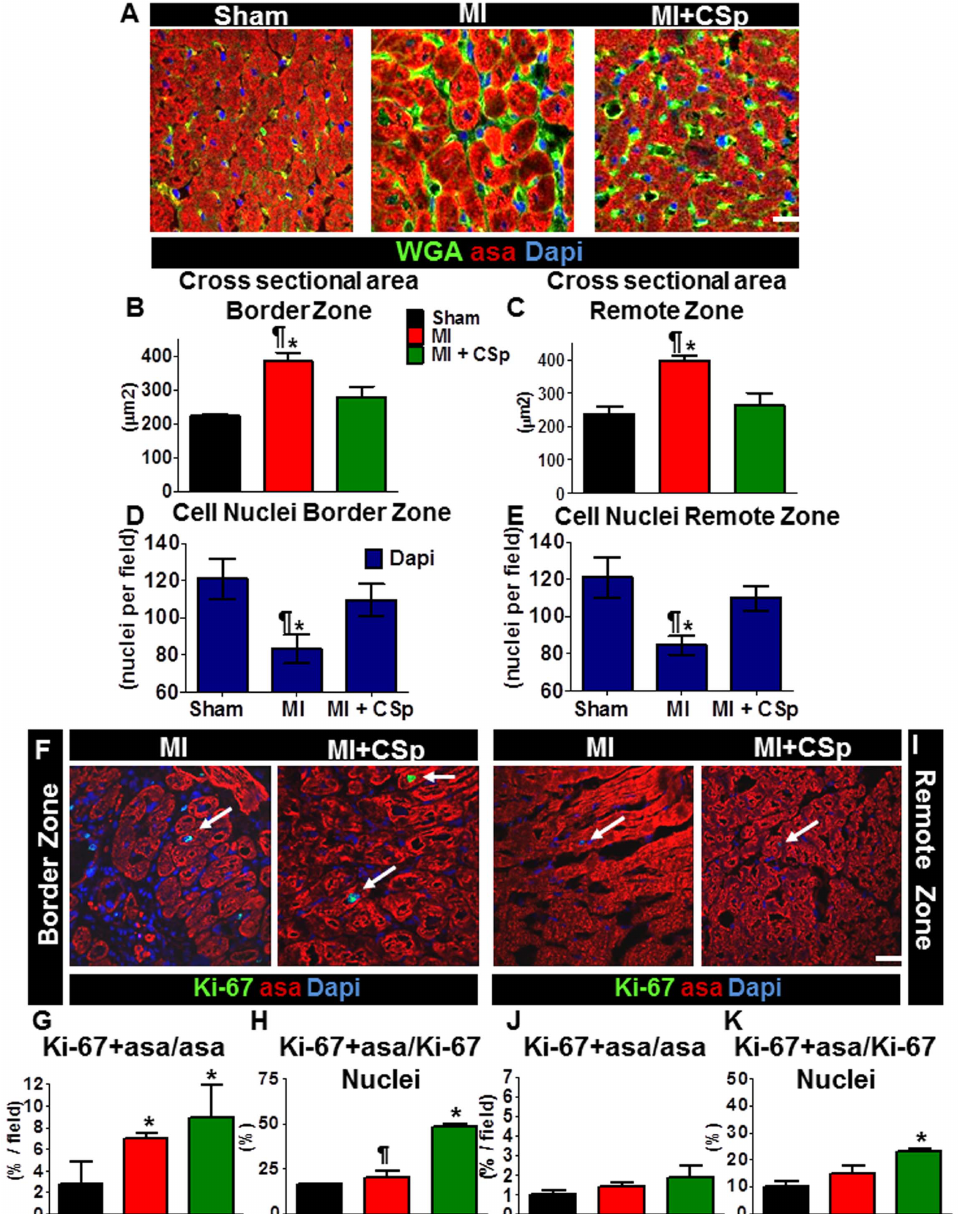
Figure 2. Cardiac tissue structure. (A) Representative photomicrographs of immunohistochemical staining of smooth muscle actin, wheat germ agglutinin, and Dapi in myocardial tissue sections. Five different heart tissues per group were stained. Approximately 10–15 high-power fields per area from a minimum 3 slides per heart were analyzed to obtain the average regional cross sectional area and regional myocyte nuclear density. 100 cardiomyocytes per heart were evaluated. (B) Quantification of cross-sectional area in the peri-infarct and D. in the remote zone respectively. (C,E) Measurement of the total number of cell nuclei per field evaluated in both above-mentioned regions. (F) Representative photomicrographs of immunohistochemical staining of a -sarcomeric actin, Ki67 and Dapi, in the peri-infarct zone and (I) in the remote area. (G–H) Quantification of proliferating cardiomyocytes per total number of cardiomyocytes per field and of proliferating cardiomyocytes per total nuclei per field respectively. (J–K) Same quantification as in G–H but in the remote area. Arrows point to Ki67 + /asa + cells. (Scale bars 50 m m). Data are mean 6 SEM. " p , 0.05 control vs. MI + CSp, * p , 0.05 vs. sham.